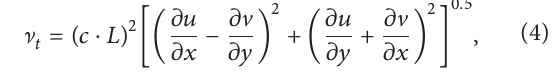
modifications were performed on this data prior to or after inclusion in the mesh. The horizontal datum utilized for the mesh was North American Datum of 1983 (NAD 83) and State Plane Coordinate System Oregon North; the vertical datum was the North American Vertical Datum of 1988 (NAVD 88). A representation of the mesh bathymetry is provided in Figure 1.